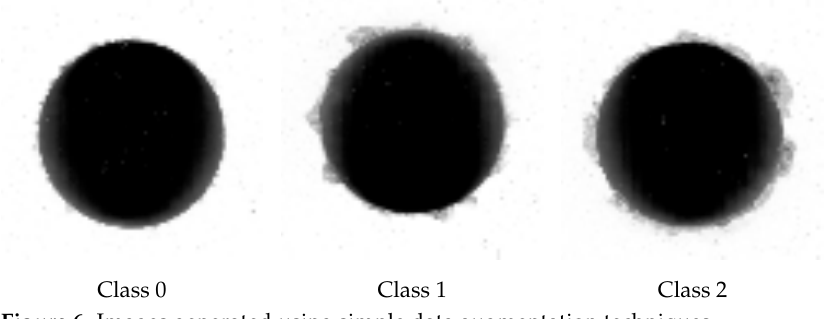
Figure 6. Images generated using simple data augmentation techniques. Table 5. Number of observations in the train dataset and its distribution between classes after data augmentation.